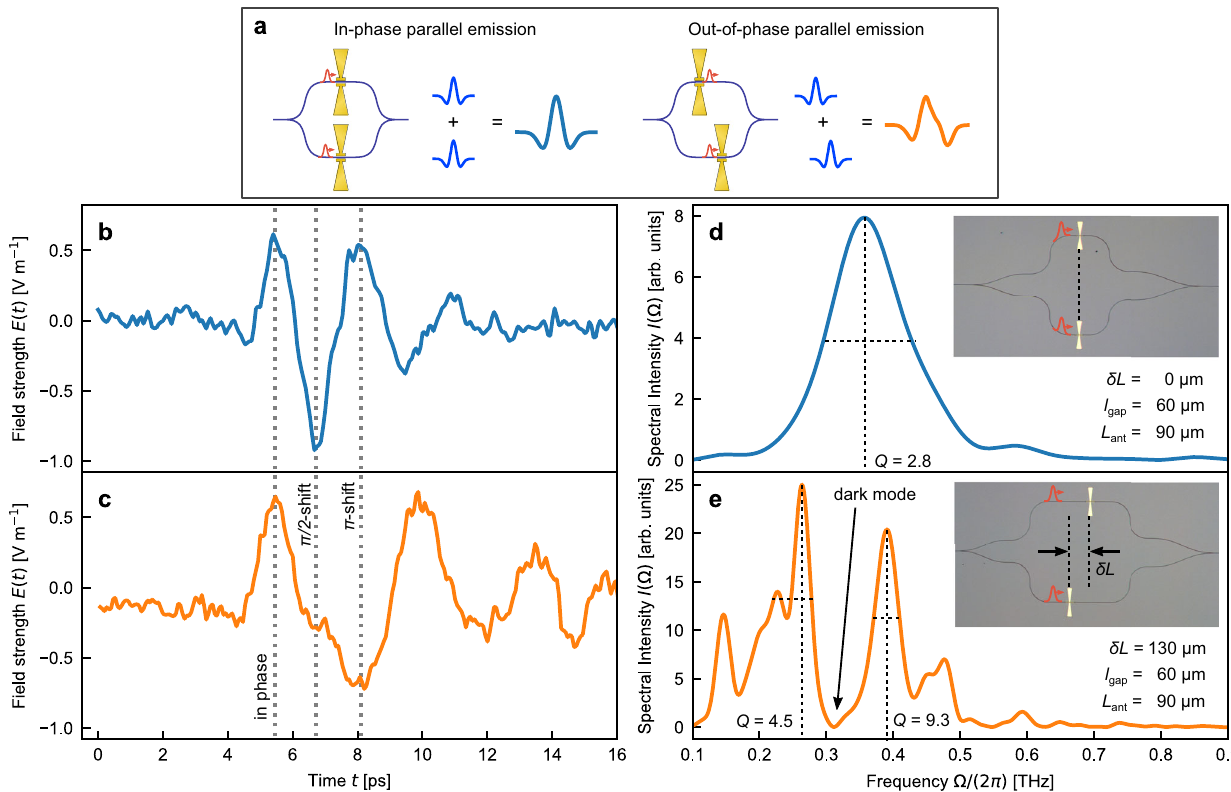
Fig.4|Theparallelblock:sub-THz-cycletemporalphasesynthesis.a Schematic difference is π /2 and at 8.1ps the phase difference is π . As highlighted by the vertical dashed lines, this phase engineering occurs on sub-THz cycle scales of the of the proposed parallel con fi guration. The on-chip pumping pulses are split into time-trace. d , e Spectral intensities corresponding to the time-traces showninplot several parallel channels using on-chip y-splitters. Antenna ’ s relative displacement δ L sets the phase relationship between the emitted THz pulses out-of-plane (in- a and b are retrieved by Fourier transform. For the in-phase emission, one broad peakwith a quality factor of Q = Ω peak ΔΩ =2 : 8 occurs. ΔΩ isde fi nedasthe fullwidth at phase or out-of-phase). The interference of these pulses determines the temporal half maximum spectral intensity around the particular peak angular frequency shapeof thefar fi eld. b , c Temporalelectric fi eldevolutionemittedbytwoin-phase ω π at the resonance fre- antennas ( δ L =0 μ m) and by two out-of-phase antennas ( δ L =130 μ m, corre- peak . For the out-of-phase emission, the phase-delay of T THz oraphase delayof π ).Allantennashavean quency leads to a suppression of the amplitude and two narrow peaks of higher sponding tohalf aTHz cycle δ L = c 0 2 n g antenna length of L ant =90 μ m and a gap length of l gap =60 μ m. The out-of-phase quality factors Q =4.5 and Q =9.3. The insets show optical microscope images of con fi guration displays different temporal phase properties than the in-phase con- the in-phase and out-of-phase fi guration:at5.5ps,thephaseofthetwowaveformsisidentical,at6.7psthephase